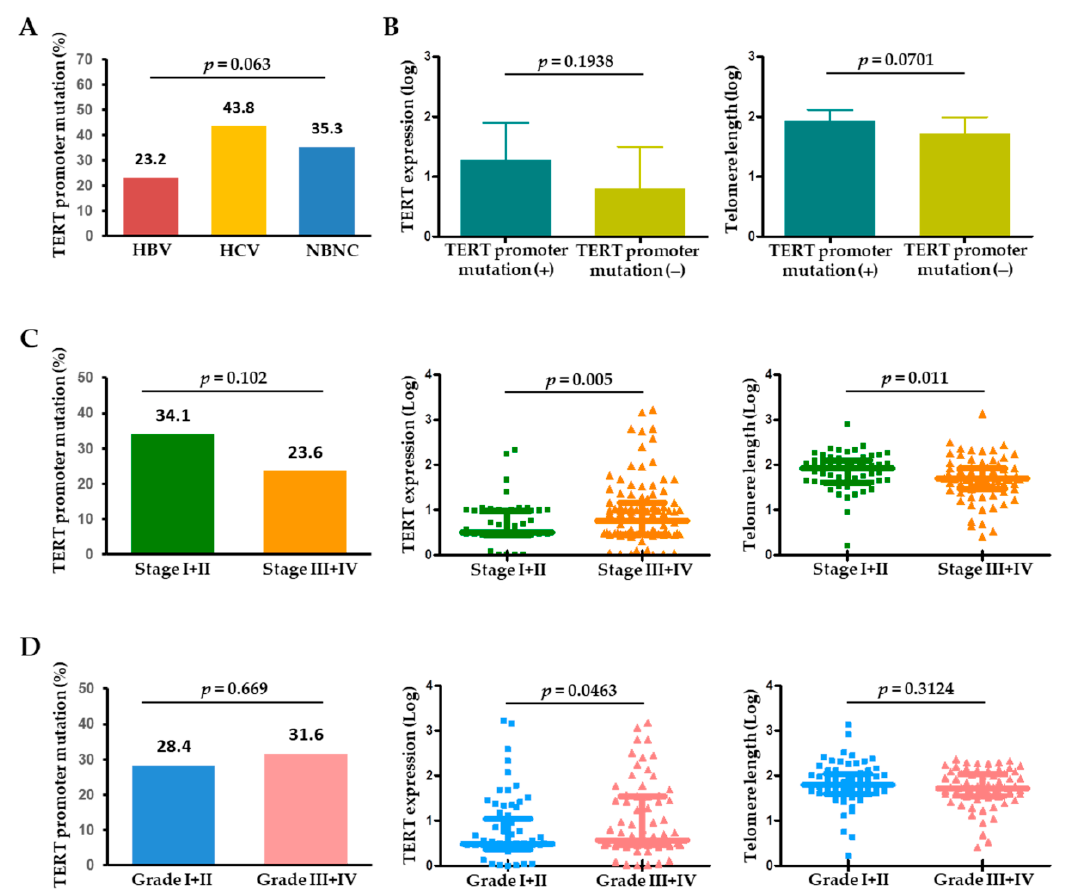
Figure 2. ( A ) Frequency of TERT promoter mutations in HCC according to the etiology of HCC. ( B ) TERT expression and telomere length in the presence or absence of TERT promoter mutations in HCC. Frequency of TERT promoter mutations, TERT expression, and telomere length according to ( C ) tumor stage and ( D ) tumor histological grade. HBV, hepatitis B virus; HCV, hepatitis C virus; NBNC, non-HBV non-HCV.